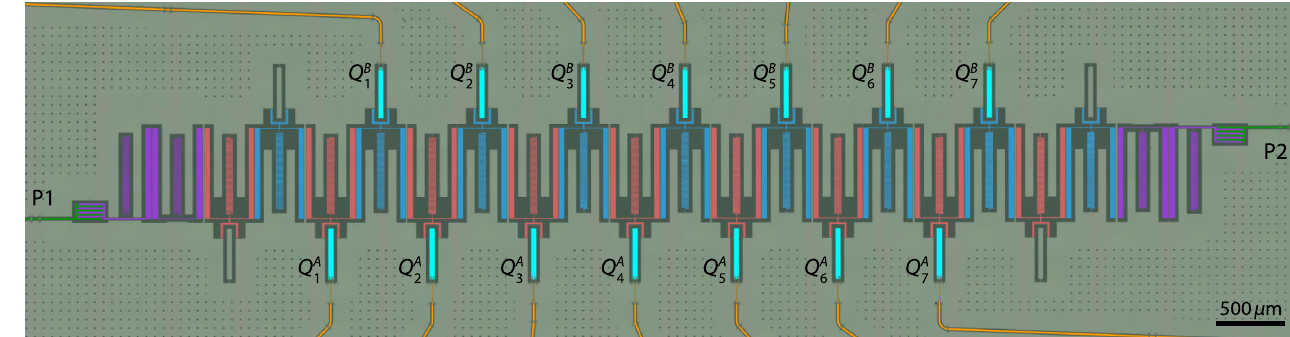
FIG. 9. Optical micrograph of device I (false colored). The device consists of a topological waveguide with 9 unit cells [resonators corresponding to A ( B ) sublattice colored red (blue)] in the trivial phase, where the intracell coupling is larger than the intercell coupling. Qubits (cyan, labeled Q α where i ¼ 1 – 7 and α ¼ A , B ) are coupled to every site of the 7 inner unit cells of the topological waveguide, j each connected to on-chip flux-bias lines (orange) for individual frequency control. At the boundary of the topological waveguide are tapering sections (purple), which provide impedance matching to the external waveguides (green) at upper band gap frequencies. P1 (P2) denotes port 1 (port 2) of the